Question: Compose a caption that would accompany this figure in a paper.
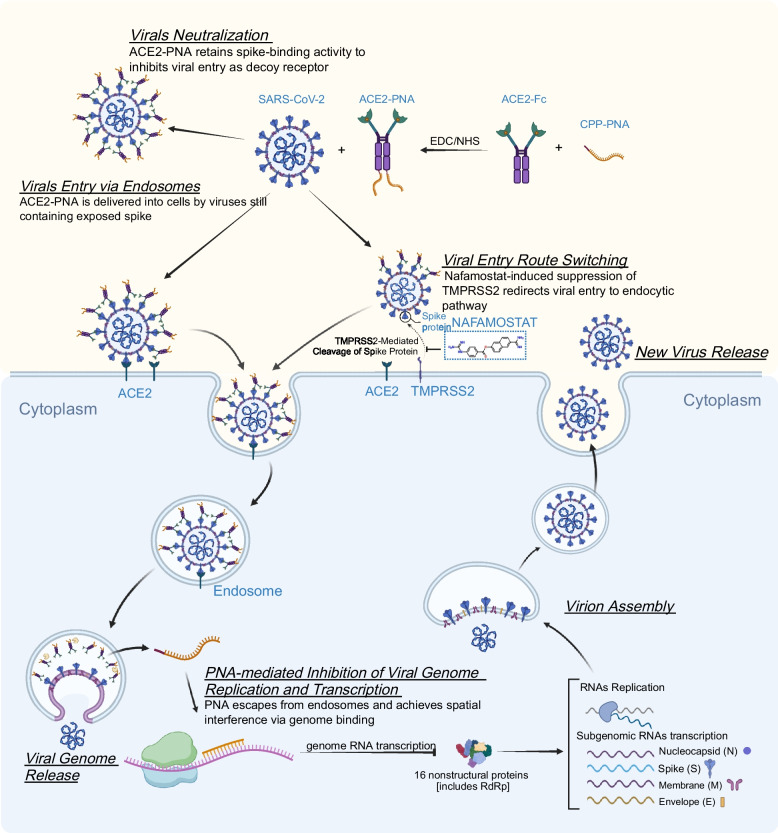
Answer: Working model of ACE2-PNA: A bifunctional antiviral strategy delivered via virus-mediated endocytosis. ACE2-PNA is a novel ACE2 derivative generated by covalent conjugation of PNA to ACE2-Fc, conferring dual antiviral efficacy acting both extracellularly and intracellularly. Here, Covalent conjugation was achieved via EDC/NHS-mediated amide bond formation. ACE2-PNA exerts dual antiviral activity: It retains the virus-neutralizing activity of a decoy receptor and simultaneously exploits the high affinity of the ACE2-Spike interaction to enable co-internalization with incompletely neutralized virions via endocytosis. Within the endolysosomal compartment, the ACE2 moiety is degraded by lysosomal acid hydrolases, while PNA, owing to its inherent protease resistance, remains intact and is subsequently released into the cytoplasm. Once in the cytoplasm, PNA binds to its target sequences (here designed within the SARS-CoV-2 ORF1ab ±30 bp region), thereby disrupting the viral life cycle. This figure is created in BioRender. Wang, Y. (2026) https://BioRender.com/79vo88s